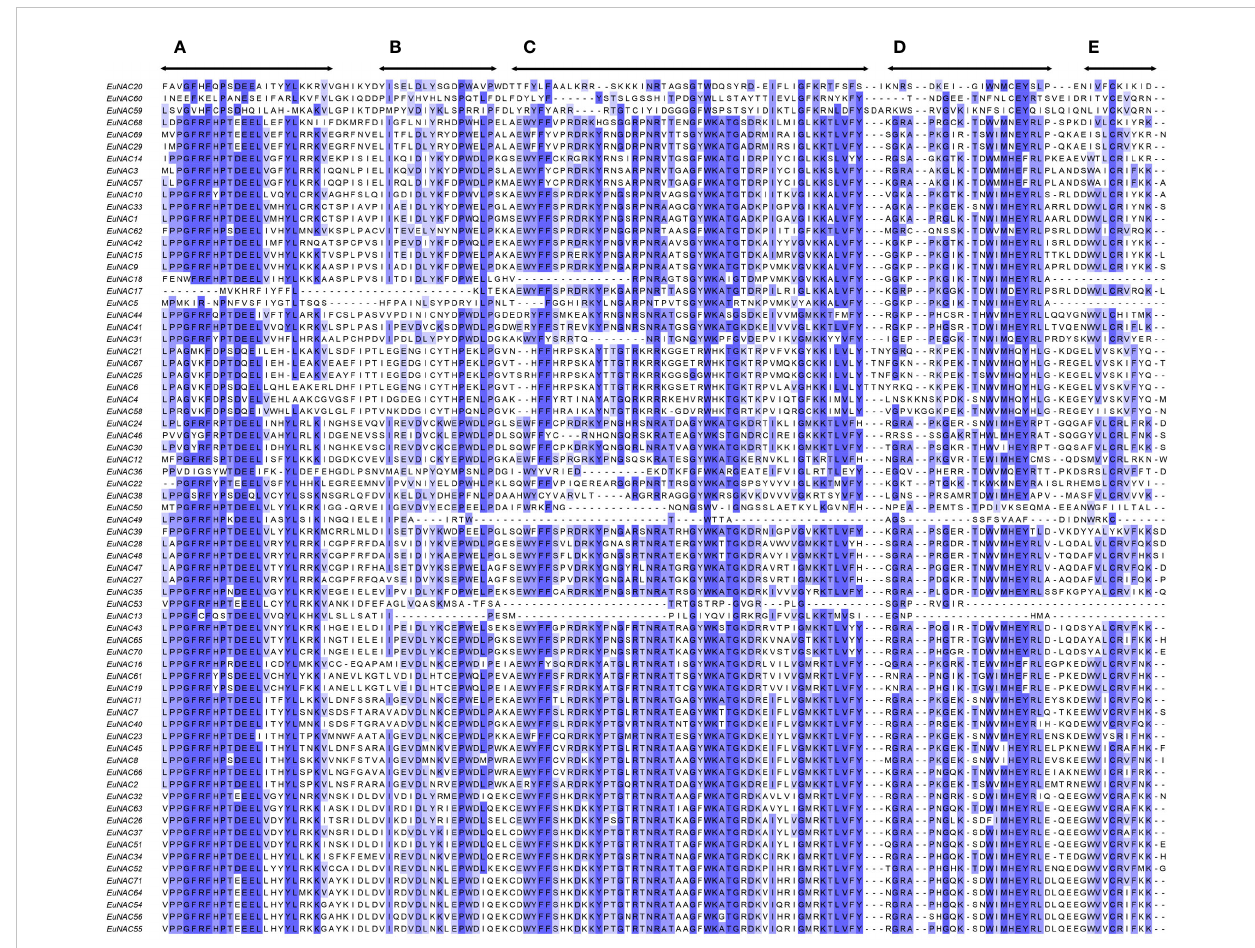
FIGURE 3 Sequence alignment of two groups of EuNAC domains amino acid sequences. Subdomains (A – E) are shown by arrows above the sequences. Overall conserved amino acids were shaded in